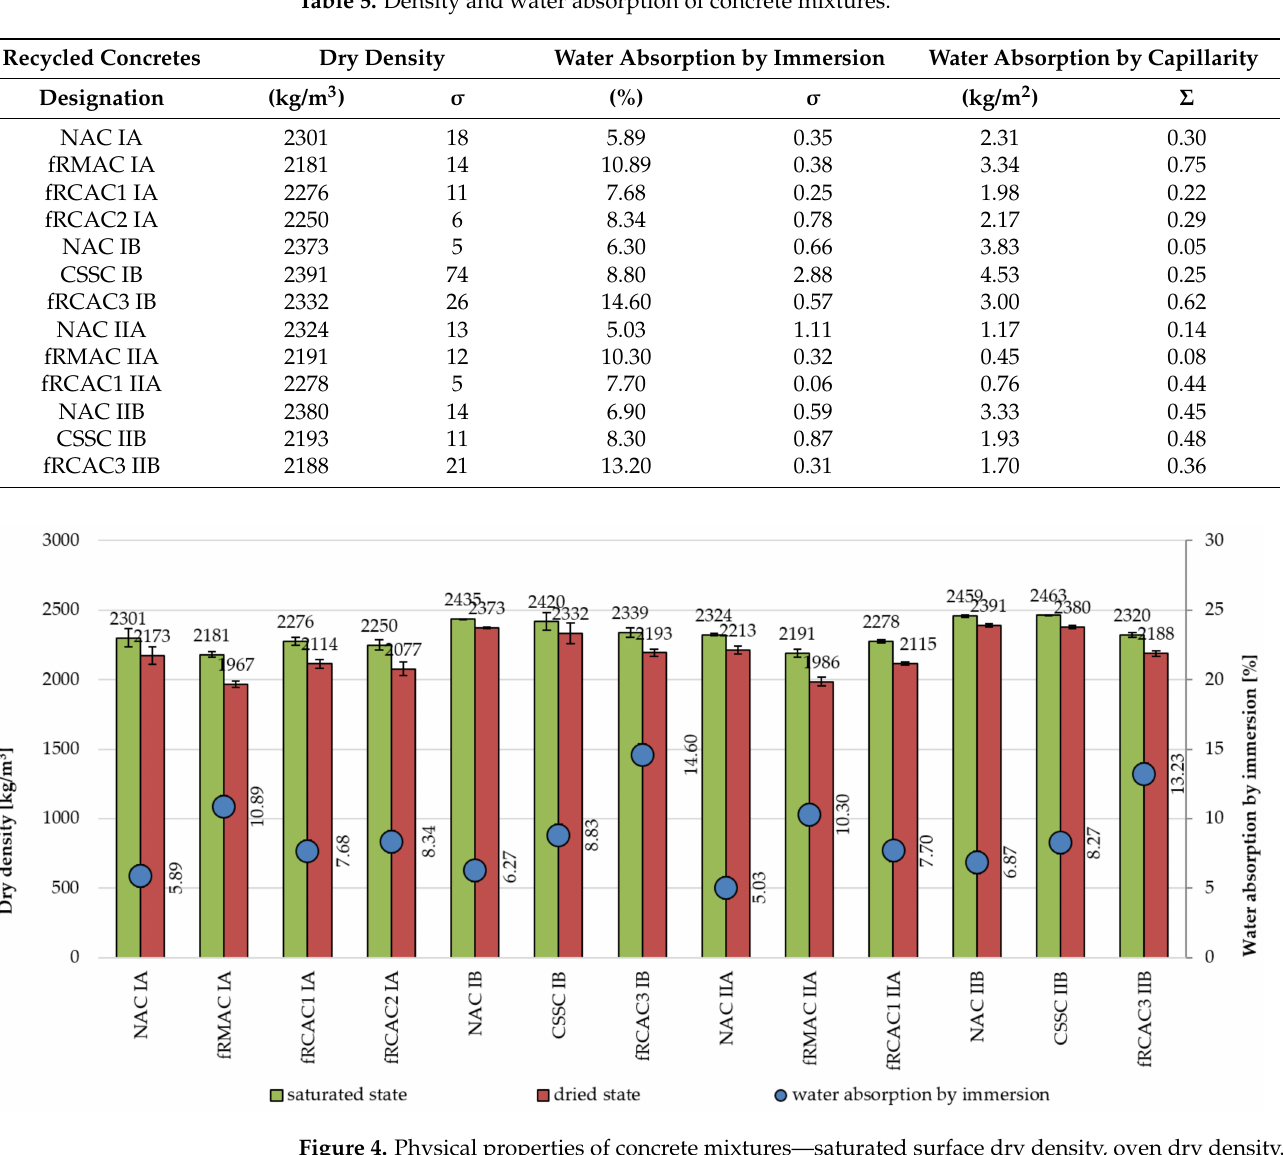
Table 5. Density and water absorption of concrete mixtures.